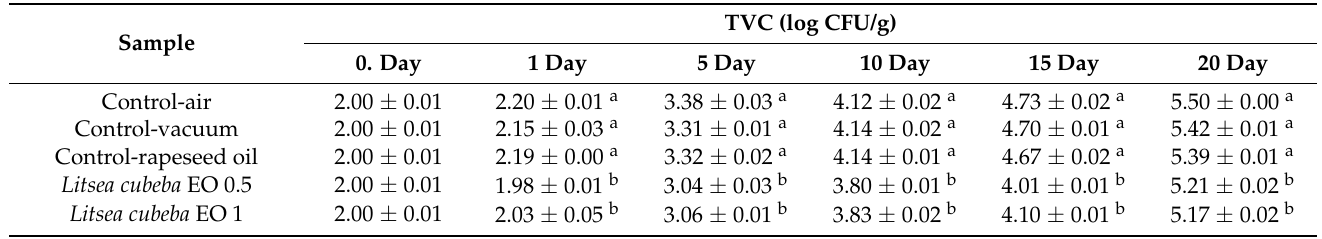
Table 1. Average numbers of total viable counts (TVC) log CFU/g in samples of deer meat during 20 days of storage at 4 ◦ C.